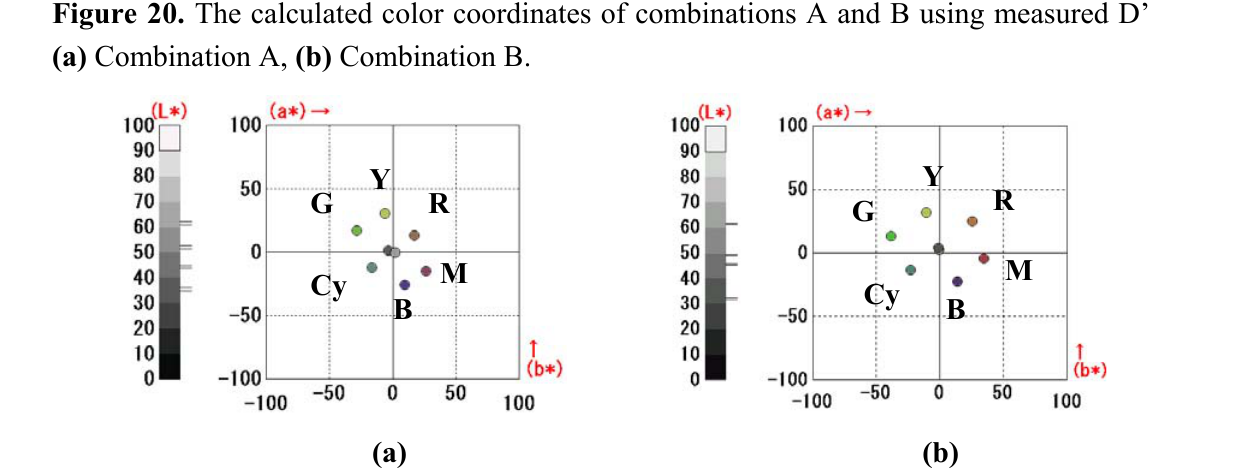
Figure 20. The calculated color coordinates of combinations A and B using measured D’